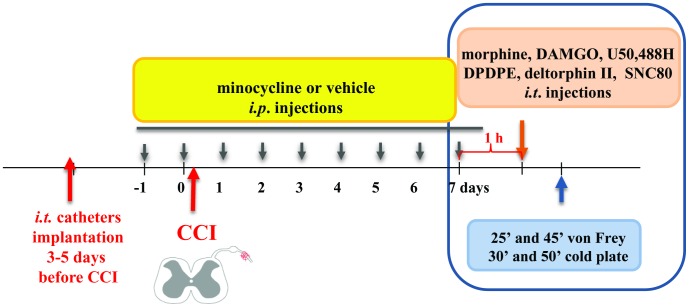
Drug administration.